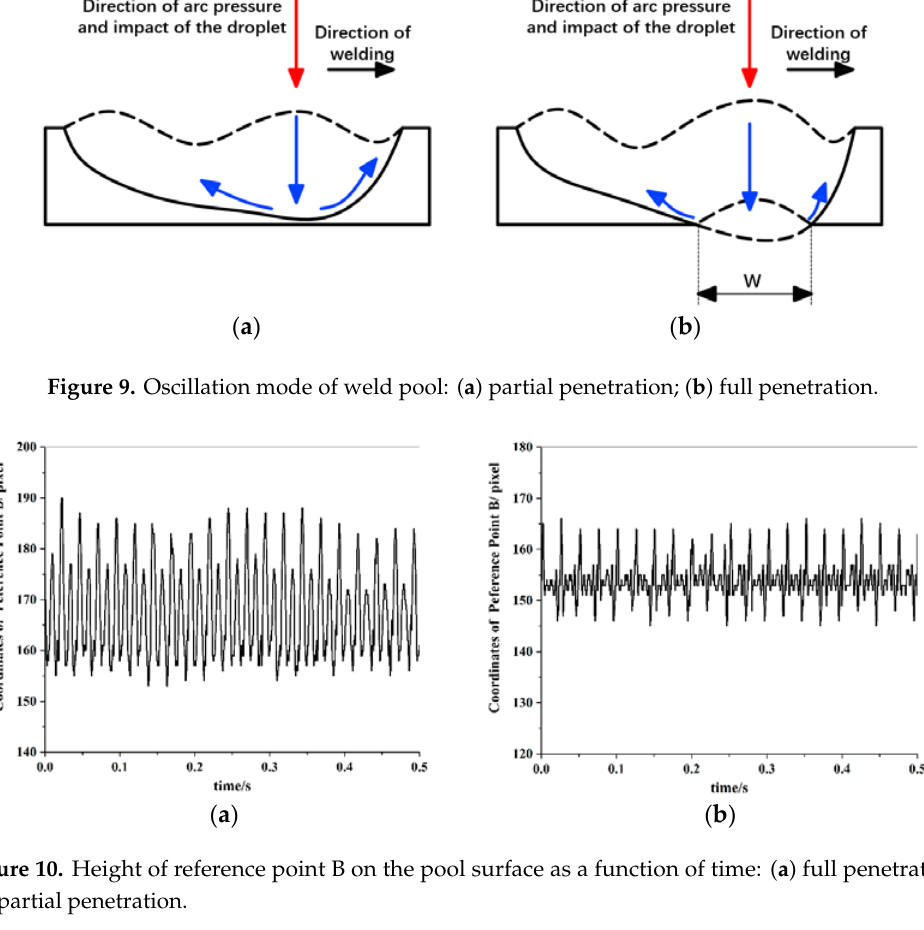
Figure 10. Height of reference point B on the pool surface as a function of time: ( a ) full penetration; ( b ) partial penetration.